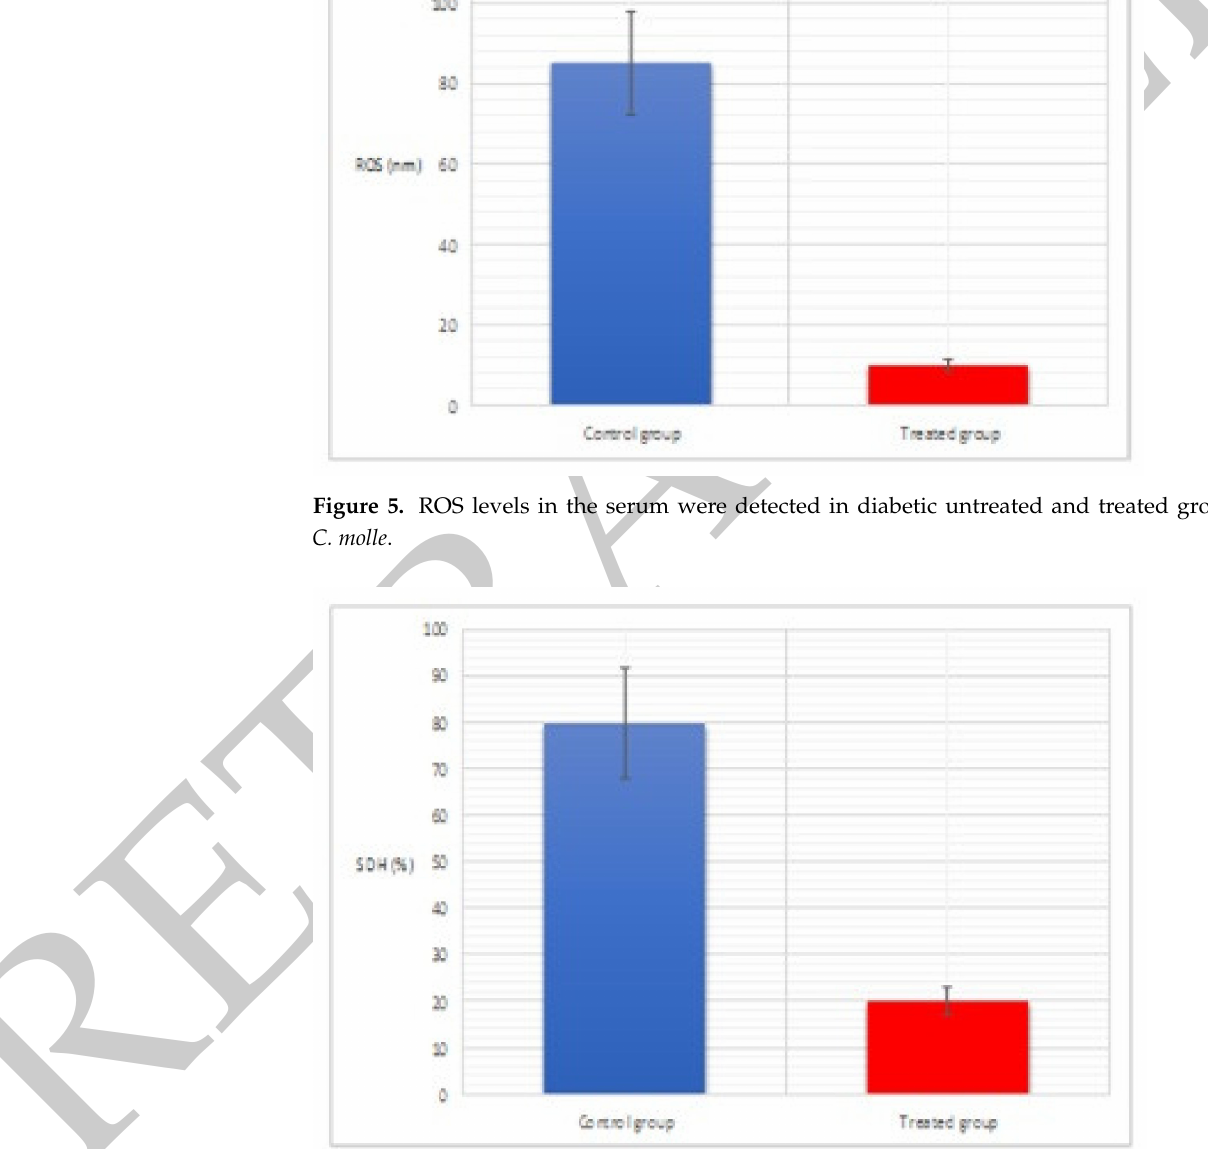
Figure 6. SDH% in the serum were detected in diabetic untreated and treated group with C. molle